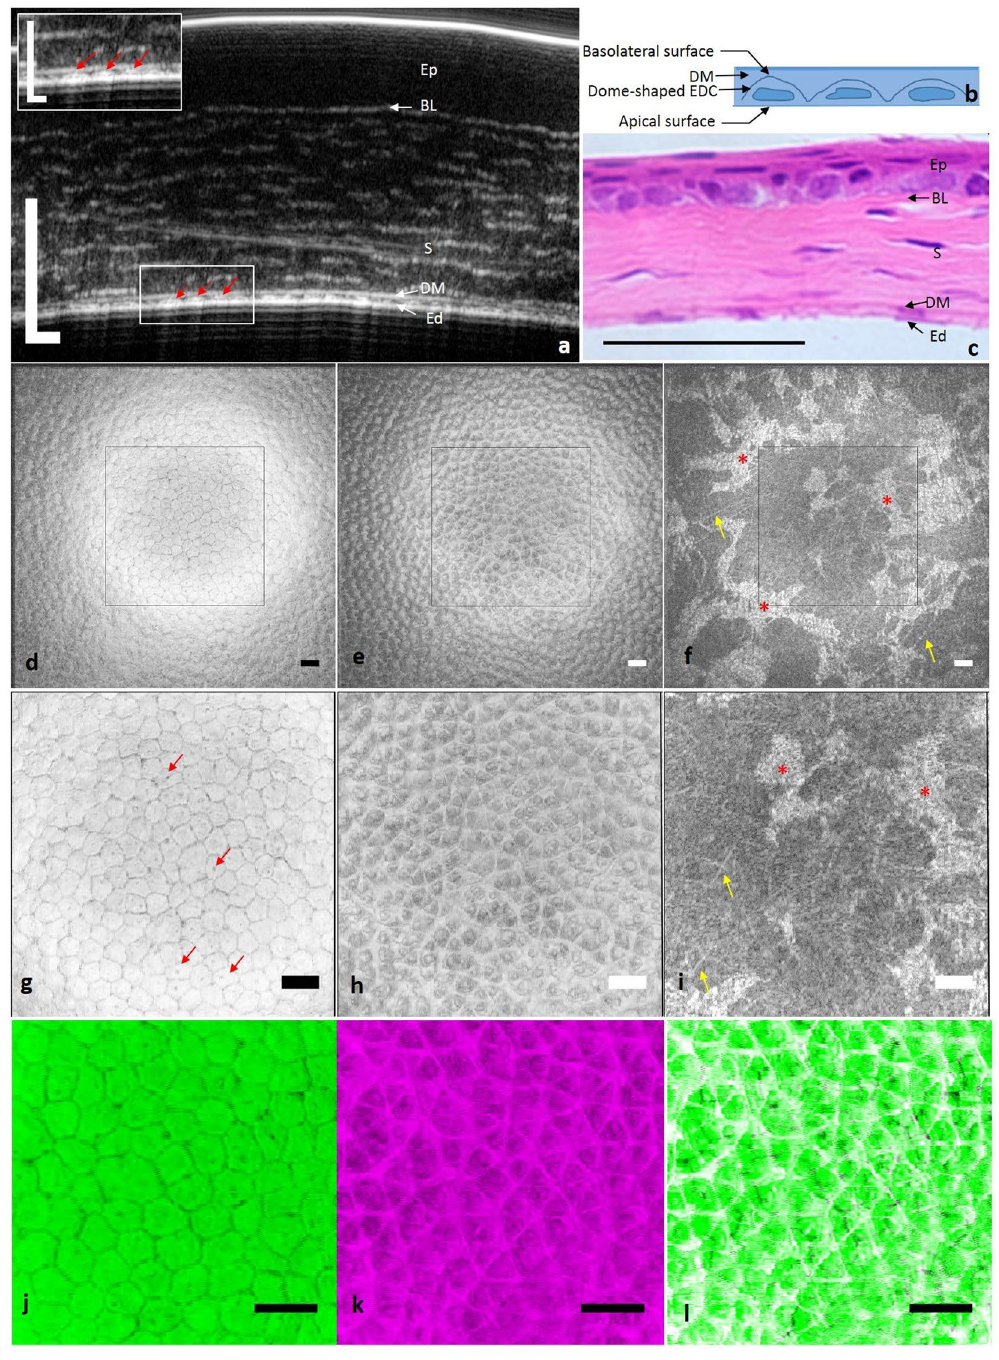
Figure 1. Ex vivo µ OCT imaging of mouse cornea. ( a ) Cross-sectional µ OCT image of mouse cornea. Inset is the zoomed-in view of the rectangular area; red arrows indicate endothelial cells. ( b ) Scheme of the tomographic view of endothelial cells. ( c ) Cross-sectional histological image of mouse cornea. ( d ) En face view of the apical side of the endothelium demonstrated regularly arranged polygonal cells with low reflective cell boundaries. ( e ) En face view of the interface between the endothelium and DM, corresponding to the basolateral side of the endothelium, presented a high scattering lattice. ( f ) En face view of posterior stroma. Stellate keratocytes (red asterisks) and linear collagen fibres (yellow arrows) were both highly reflective. ( g – i ) Zoomed-in view of the square region in ( d – f ). Dark spots are probably primary cilia of endothelial cells (red arrows in g ). ( j ) Apical surface of endothelial cells. ( k ) Basolateral surface of endothelial cells. ( l ) Overlap of apical and basolateral surface of endothelial cells. Ep: epithelium; BL: Bowman’s layer; S: stroma; DM: Descemet’s membrane; Ed: endothelium; EDC: endothelial cell (Scale bar = 50 µ m and scale bar of inset in ( a ) represents 25 µ